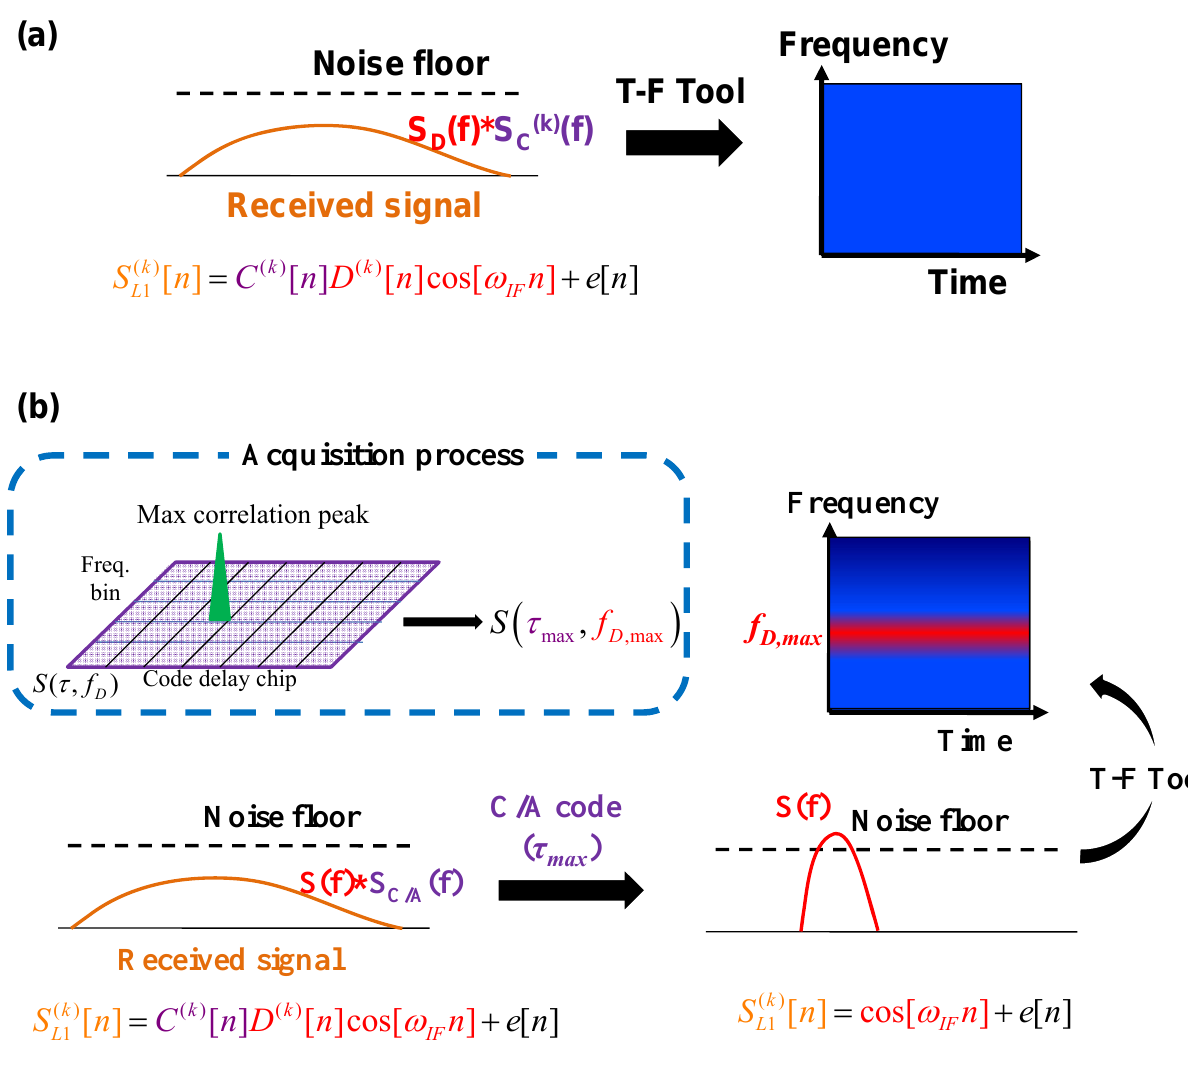
Figure 5. (a) An example of mapping a raw GPS signal into the time-frequency plane by a time-frequency tool. (b) The concept of satellite signal detection by using the time- frequency